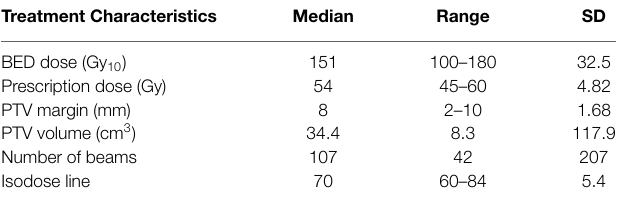
TABLE 2 | Treatment Characteristics